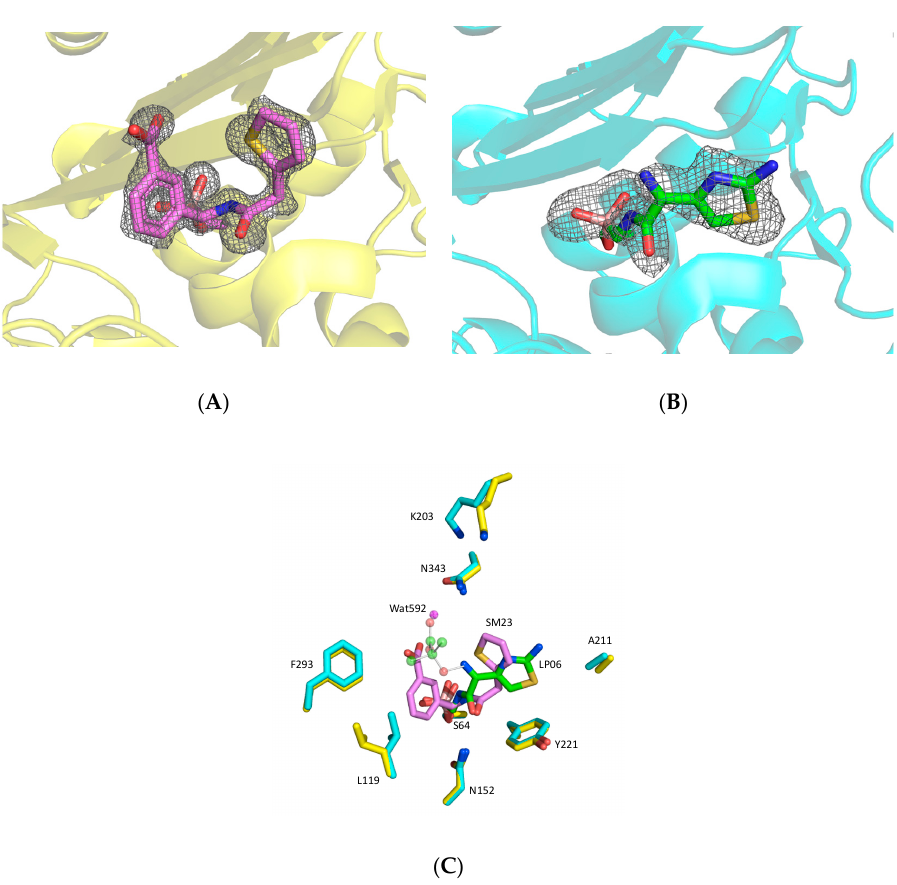
Figure 3. Comparison of BATSIs binding to FOX-4. ( A , B ) Omit maps of the ligand electron density were contoured at 3.0 R.M.S.D. for SM23 (CEF analog) and LP06 (CAZ analog) (A and B, respectively). ( C ) Overlay of the FOX-4/SM23 complex (yellow/violet) and FOX-4/LP06 complex (cyan/green) structures. The BATSIs adopt very different conformations. The aminothiazole ring of LP06 forms edge-to-face π -stacking interactions with Y221, while the thiophene ring of SM23 points away. The amide carbonyls both form hydrogen bonds with N152. The missing electron density for LP06 is modeled by the structure from E. coli AmpC (PDB: 1IEM). L119 moves away in the SM23 structure.